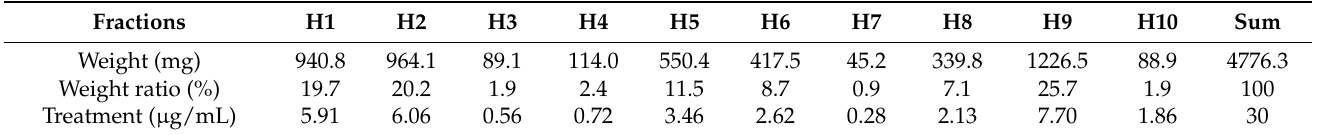
Figure 2. Dual mode CPC chromatogram of n -hexane extract of L. strychnifolia . The details are described in Section 3.6 CPC procedure. Table 2. Fraction weights and calculated concentrations.